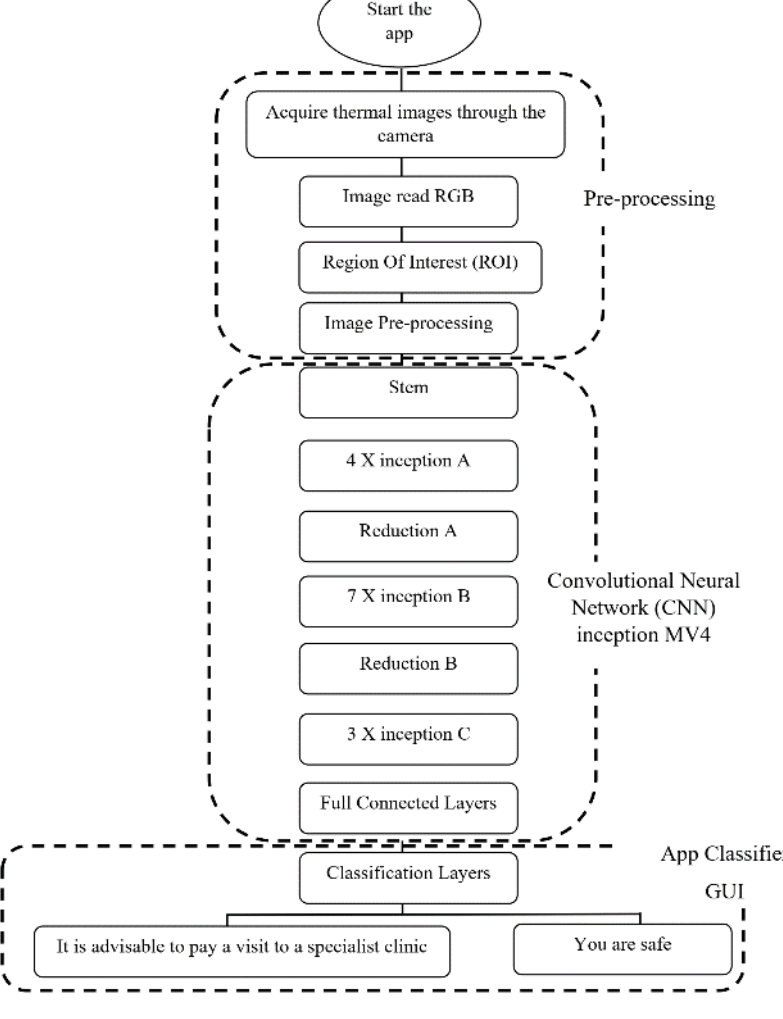
Figure 6. Block diagram of the proposed research.